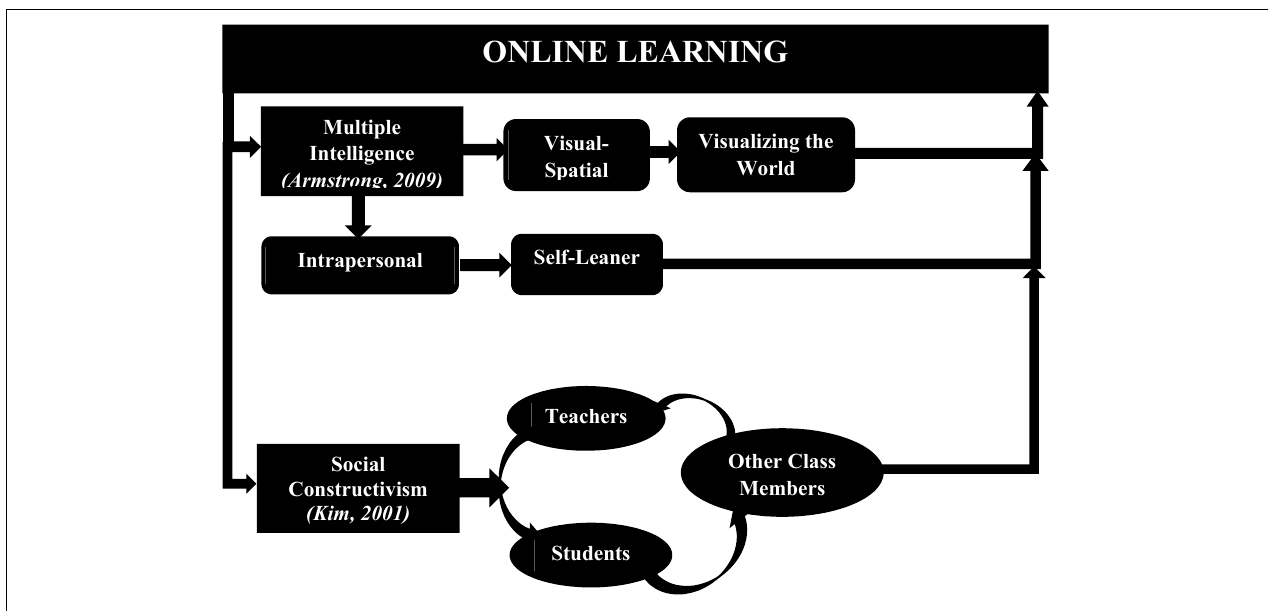
FIGURE 1 | Theoretical Framework made by authors with the help of Kim (2001), Armstrong (2009).